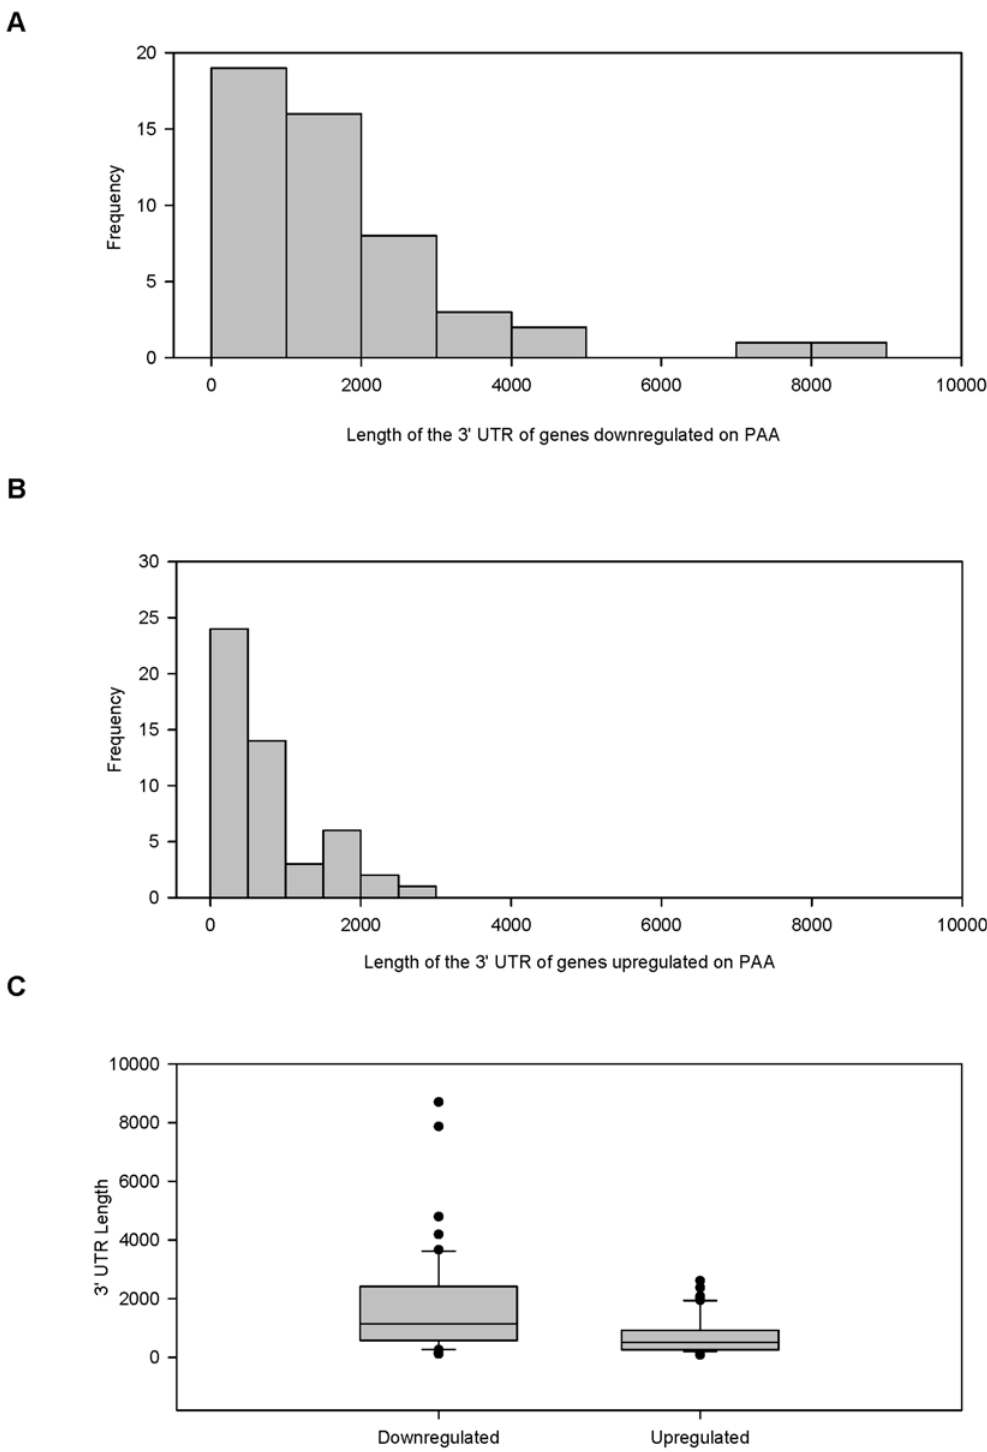
Fig 6. Greater proportion of probes downregulated on PAA have a longer 3' UTR. A random samples of 50 probes upregulated on PAA (FC > 2) was compared to 50 probes highly downregulated on PAA (FC < -10). MicroRNA target sites were predicted from the 3' UTR of each probe for each set using the microRNA.org resource using a conserved mirSVR scores of < -0.1 as a filter to collect predicted miRNA target sites. Histograms of the length of the 3' UTR for the probes (A) downregulated on PAA and (B) upregulated on PAA. (C) Box plot that compared the distribution of the two sets of probes.